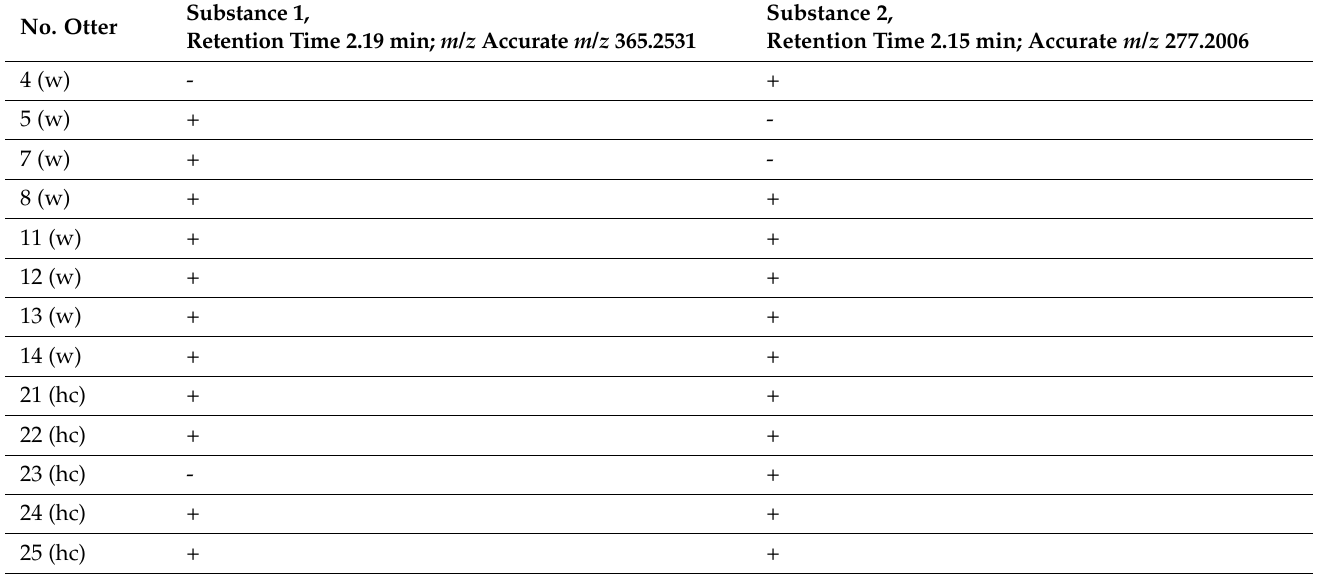
Table 3. Substances 1 and 2 in the mass spectrometry in wild otters (w) and otters under human care (hc). Presence (+) and absence (-) of any substance is